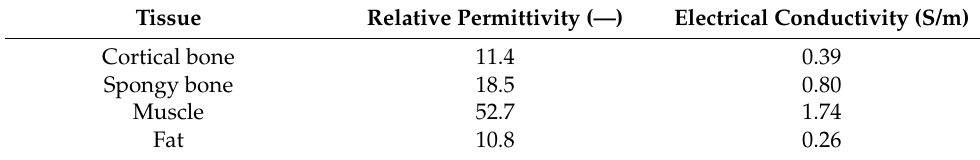
Table 3. Dielectric tissue properties at 2.45 GHz to be emulated in the tissue phantoms [48]. Tissue Relative Permittivity (—) Electrical Conductivity (S/m) Cortical